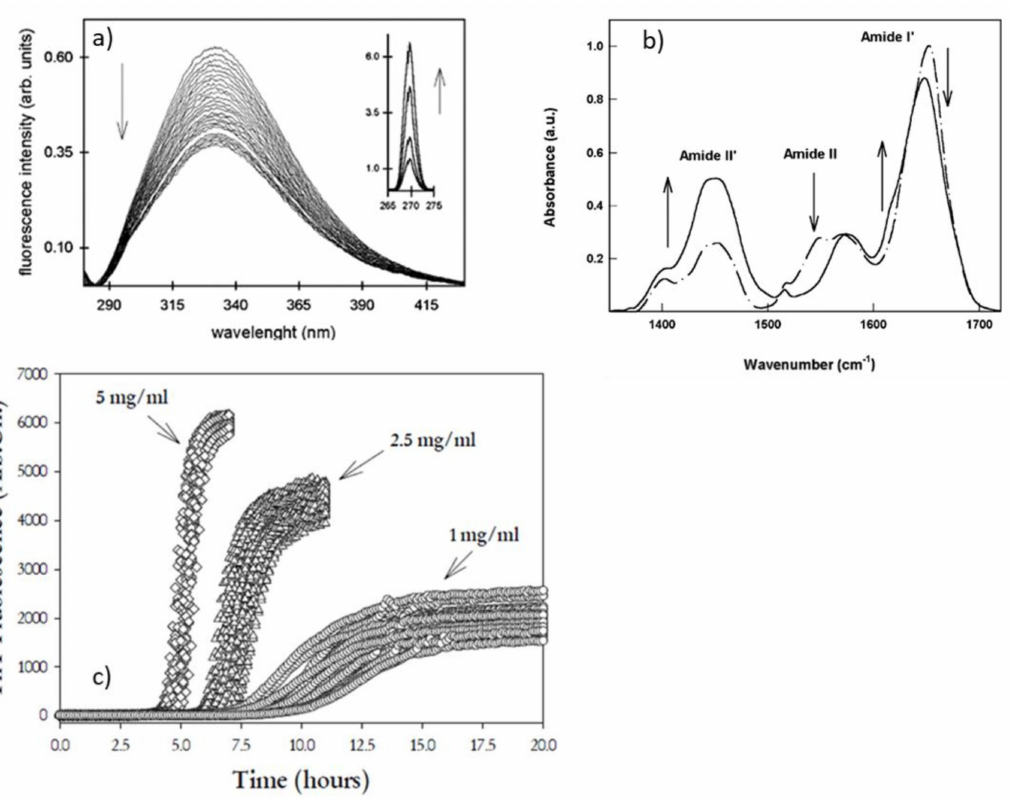
Figure 4. Representative kinetics measurements on multiple observables that can be used to monitor the complexity of supramolecular assembly. ( a ) Time evolution of intrinsic fluorescence of BSA during incubation at high temperature; the inset shows Rayleigh scattering growth occurring simul- taneously [66]. ( b ) FTIR spectra of BSA in its native form (dashed-dotted line) and in the aggregate aggregated form (solid line) [72]. Reprinted from Refs. [66,72] with permission from Elsevier (license number 5405291430367, 5405300216637). ( c ) ThT fluorescence kinetics for a human insulin sample at three different protein concentrations. Reprinted with permission from Ref. [82]. Copyright 2008 American Chemical